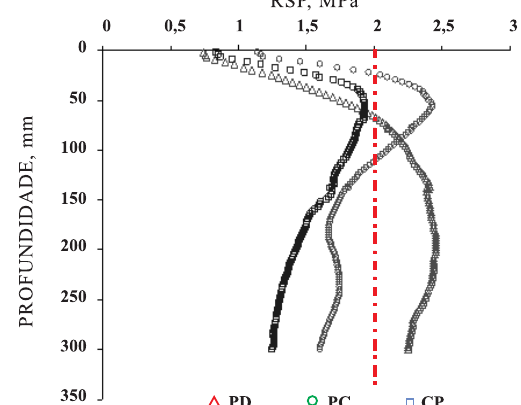
Figura 1. Curvas de resistência mecânica do solo à penetração média (RSP), em função da profundidade, observadas em Latossolo Vermelho-Amarelo distrófico sob plantio direto (PD), pastagem cultivada (PC) e Cerrado nativo pastejado